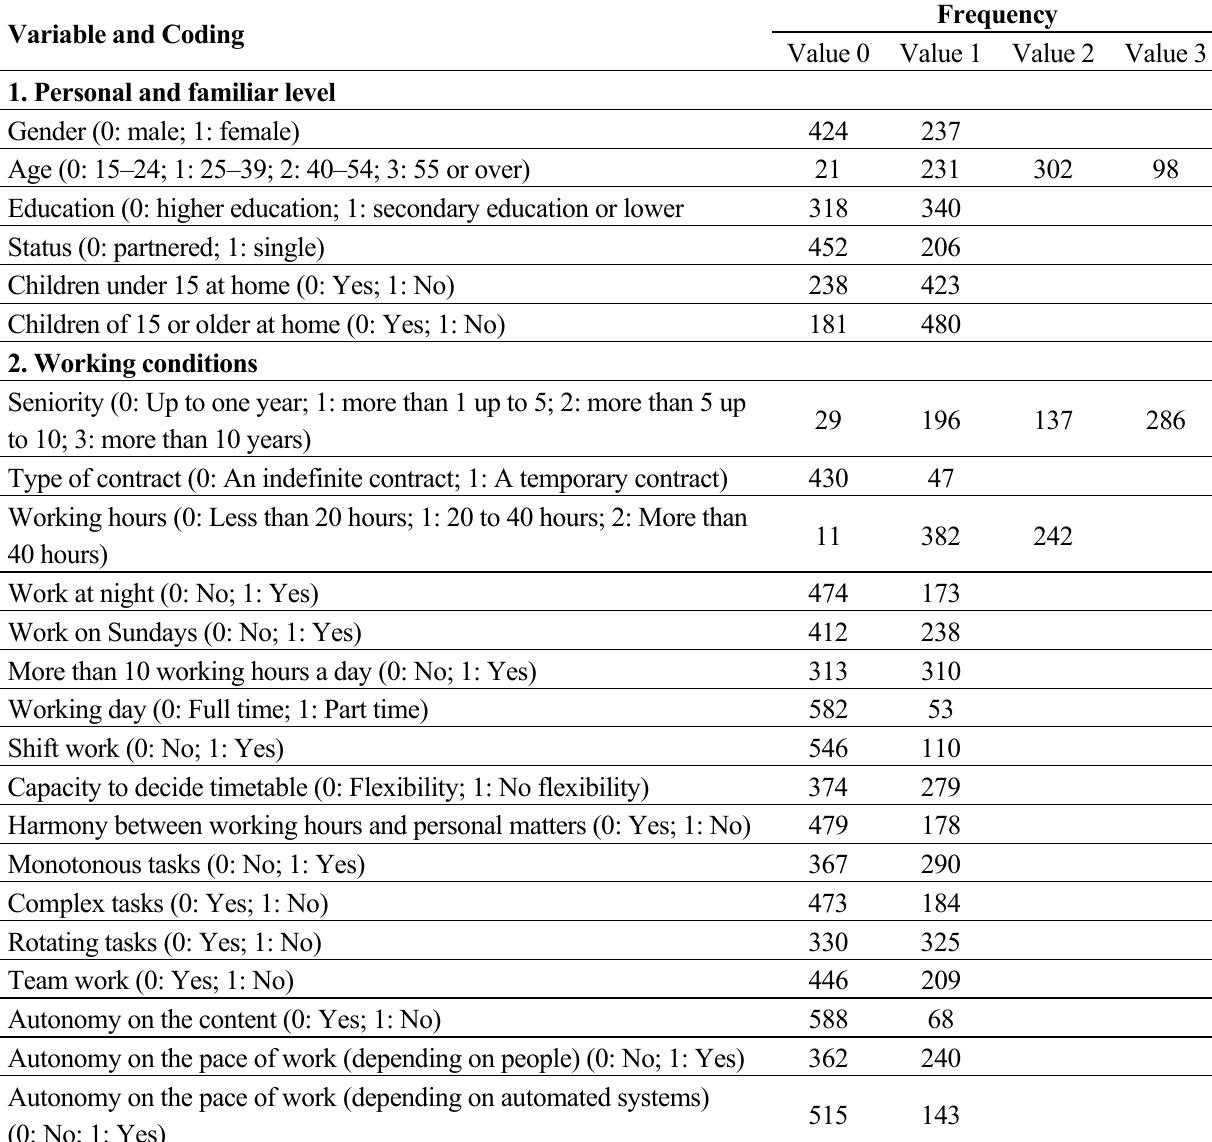
Table 1. Explanatory variables: coding and